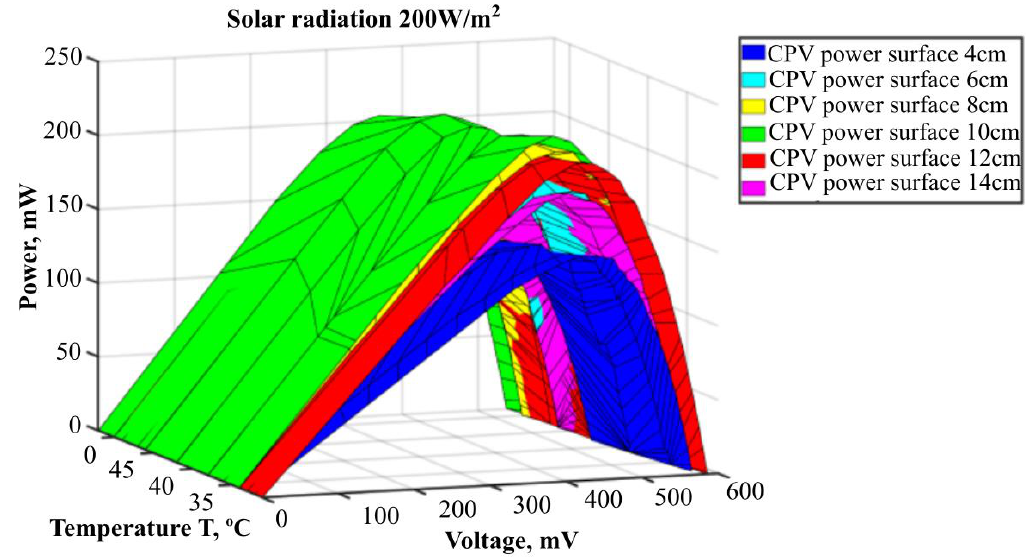
Figure 5. Graphs of CPV power at different heights of the Fresnel lens relative to the solar cell at different temperatures and constant incident radiation power of 200 W/m 2.